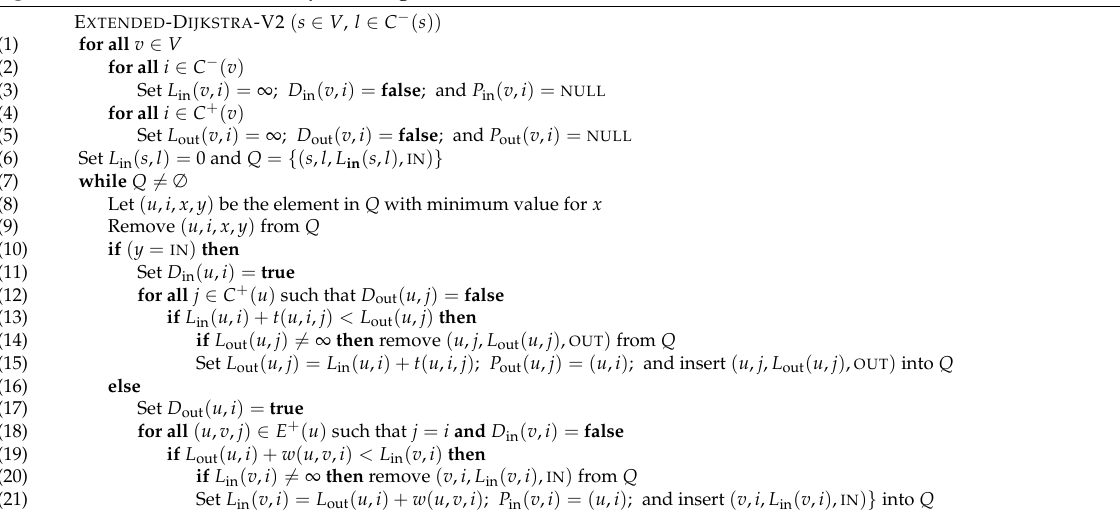
Algorithm 4 The extended Dijkstra algorithm, version